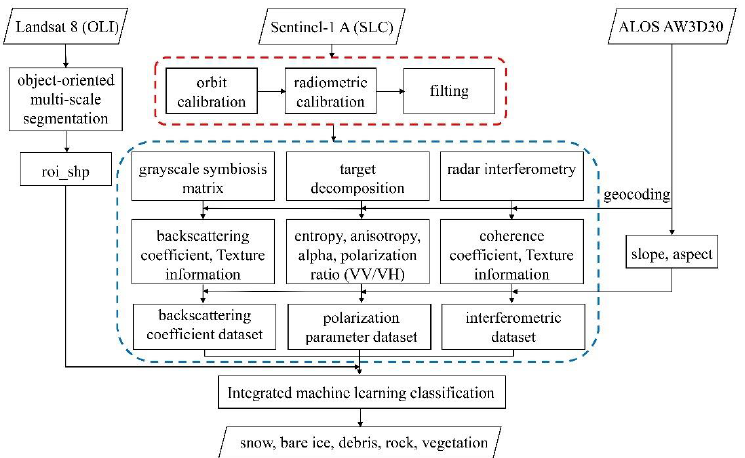
Figure 3. The flowchart for data processing. The dashed red box indicates the pre-processing of the radar data, and the blue dashed box indicates the generation of multiple data suites of backscattering coefficients, polarization decomposition parameters, and interferometric coherence coefficient. Five land surface classes are obtained from the integrated machine learning classification algorithm.